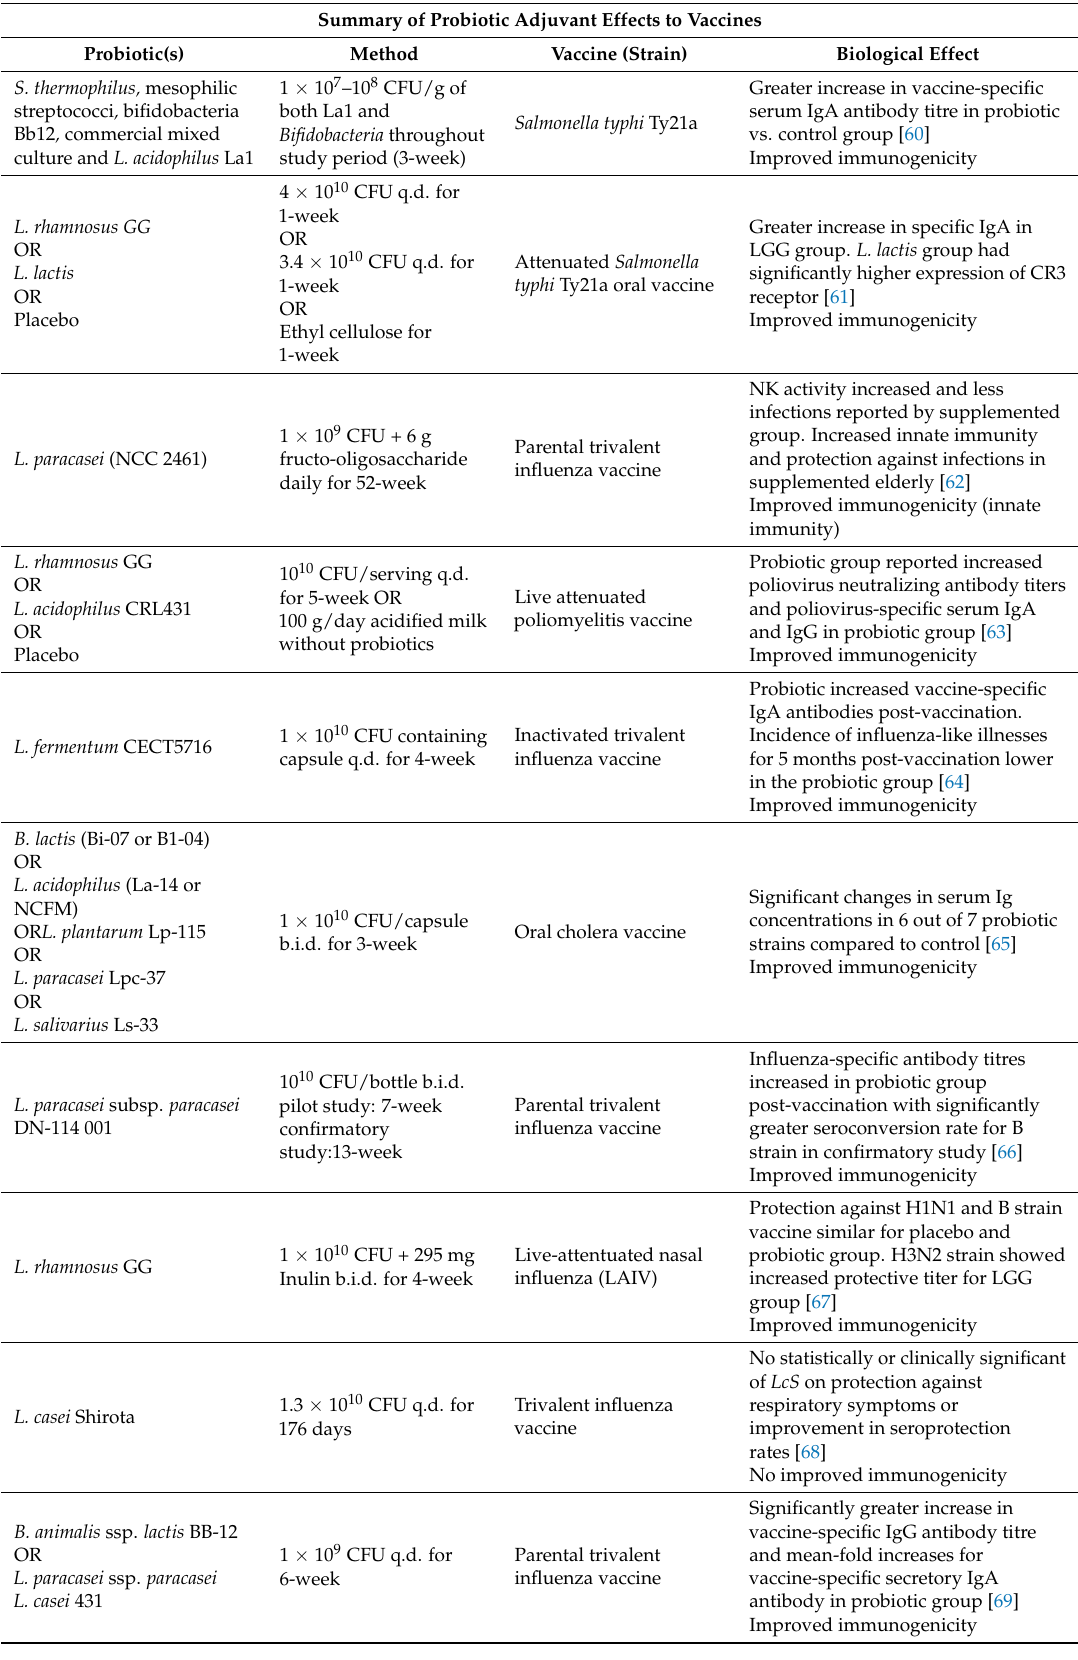
Table 2. Clinical studies investigating the effects of probiotics on vaccine responses in